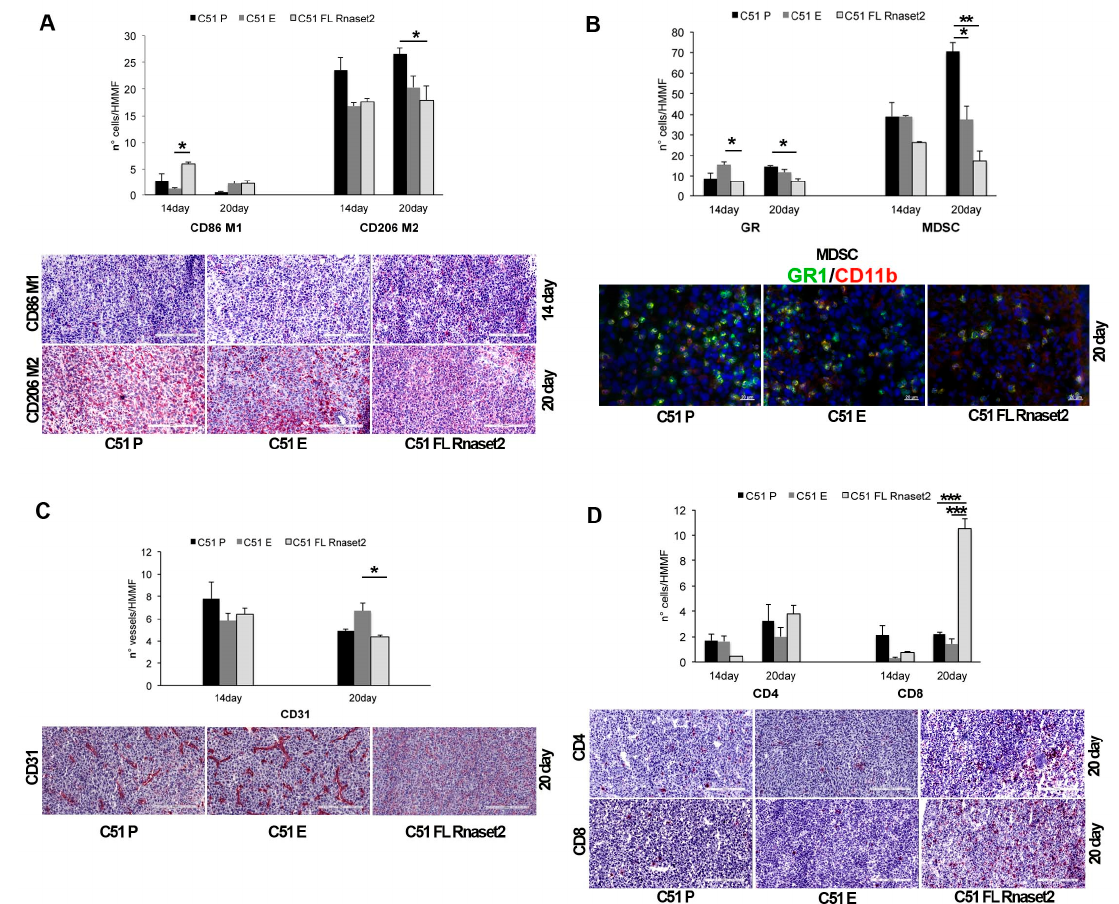
Figure 5. Quantification of different key markers of tumor infiltrating immune cells, as follows: CD86 + M1 and CD206 + M2 (panel A ), Gr-1 (GR) for granulocytes and CD11b + Gr-1 + for MDSCs (panel B ), CD31 for vessels (panel C ), and CD4 and CD8 for T cells (panel D ) per HMMF in BALB/c mice injected with C51 P, C51 E, and C51 FL Rnaset2 cell lines ( N = six animals in group). The mean ± SE are indicated. Immunohistochemistry and immunofluorescence analyses of tumor sections from BALB/c mice injected with C51 P, C51 E, and C51 FL Rnaset2 cell lines at indicated time points are shown. An ANOVA statistical analysis was performed assuming p < 0.05 as a threshold value. * p < 0.05; ** p < 0.01; *** p < 0.001.